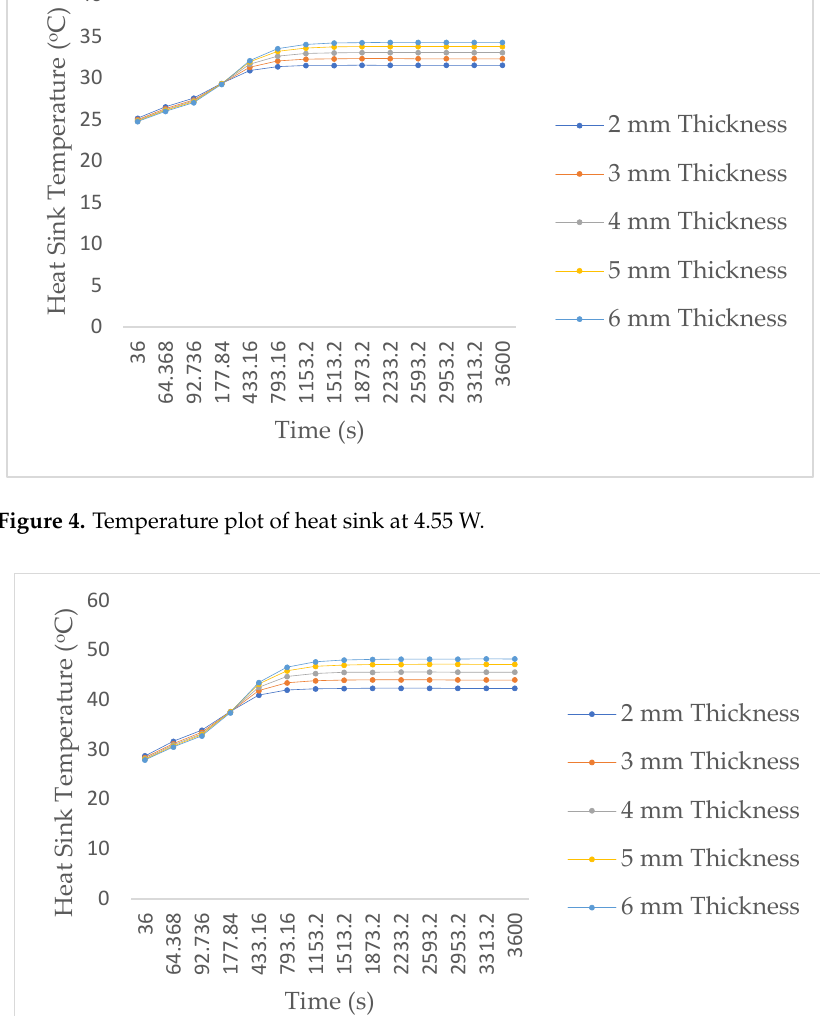
Figure 6. Temperature plot of heat sink at 15.03 W.